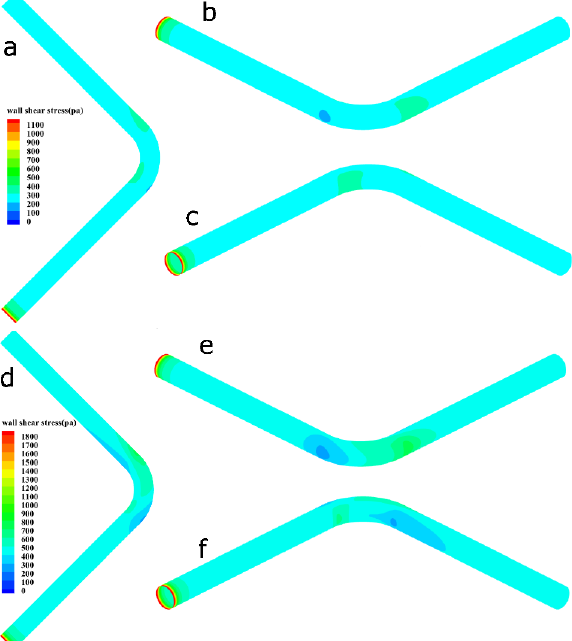
Figure 3. ( a ) Top view of the distribution of the wall shear stress in the 90° channel at the flow rate of 2.85 cm 3 /s. ( b ) The distribution viewed from the outer bend in the same case as ( a ). ( c ) The distribution viewed from the inner bend in the same case as ( a ). ( d ) Top view of the distribution of the wall shear stress in the 90° channel at the flow rate of 4.75 cm 3 /s. ( e ) The distribution viewed from the outer bend in the same case as ( d ). ( f ) The distribution viewed from the inner bend in the same case as ( d ).